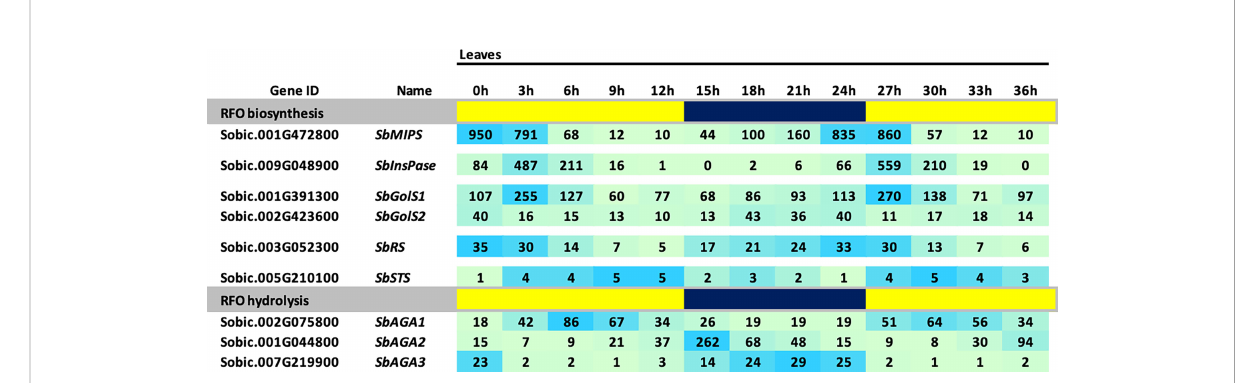
FIGURE 4 Diel expression of RFO metabolism genes in BTx623 leaves. Yellow highlighted regions indicate lights-on and blue regions indicate lights off. Photoperiod was 14 HL:10HD. Numeric data represents TPM normalized expression. Each data point is the mean of three biological replicates. In the heat map, the darker the blue the higher the